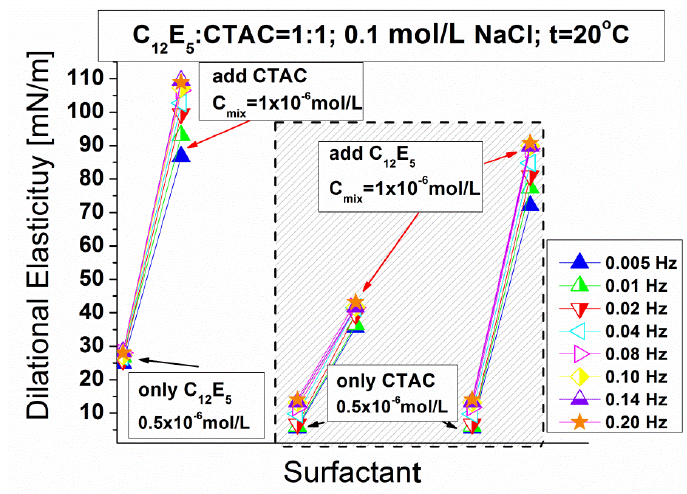
Figure 10. Dilatational elasticity change after addition of second component: C 12 E 5 is added to existing CTAC adsorption layer and CTAC addition to C 12 E 5 adsorption layer; the final solutions are 1:1 mixtures with total surfactant concentration’s 1.0 × 10 −6 mol/L.